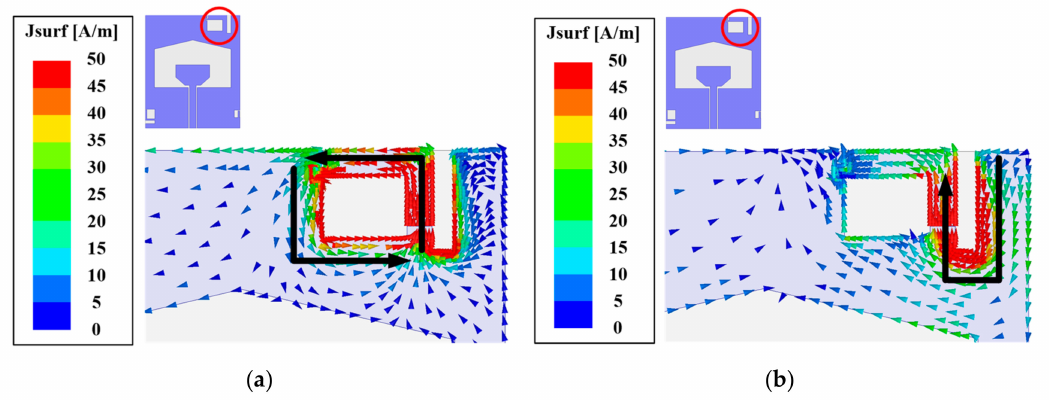
Figure 6. Simulated surface current distributions of NB Antenna #1 ( a ) at 3.5 GHz and ( b ) at 4.9 GHz.